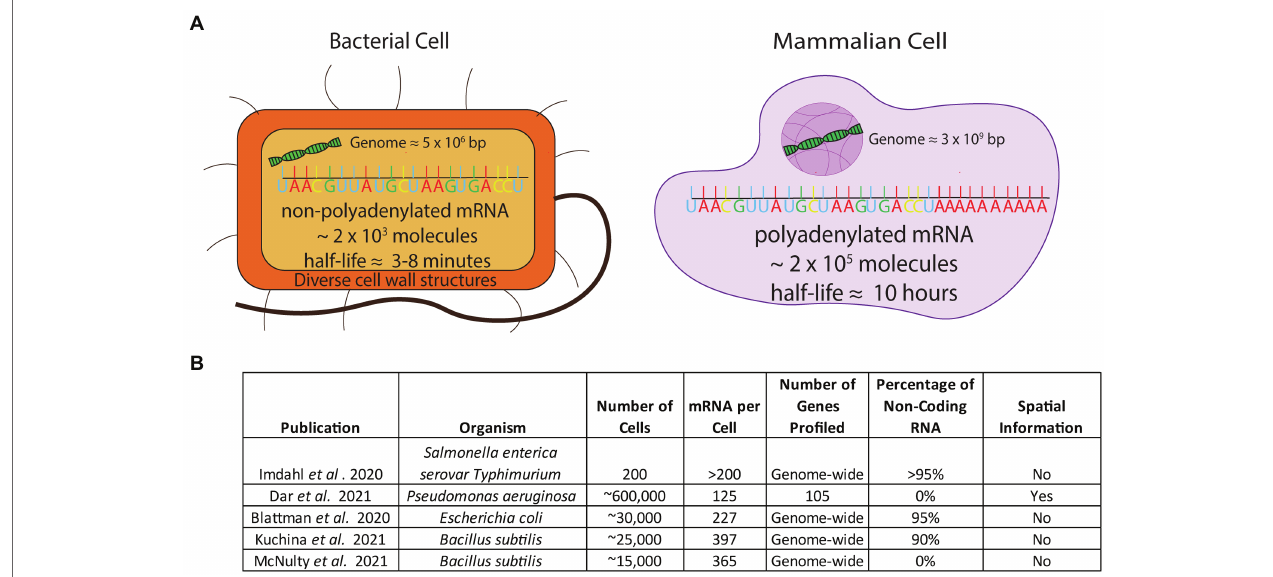
FIGURE 1 | (A) Comparison of the challenges in applying scRNA-seq to bacterial cells. Bacterial cells have non-poly-adenylated mRNA transcripts, a low mRNA content, a short half-life, and a high percentage of rRNA composing their transcriptome and have diverse, thick cell walls which make permeabilization difficult (B) Studies that have addressed challenges to apply scRNA-seq to